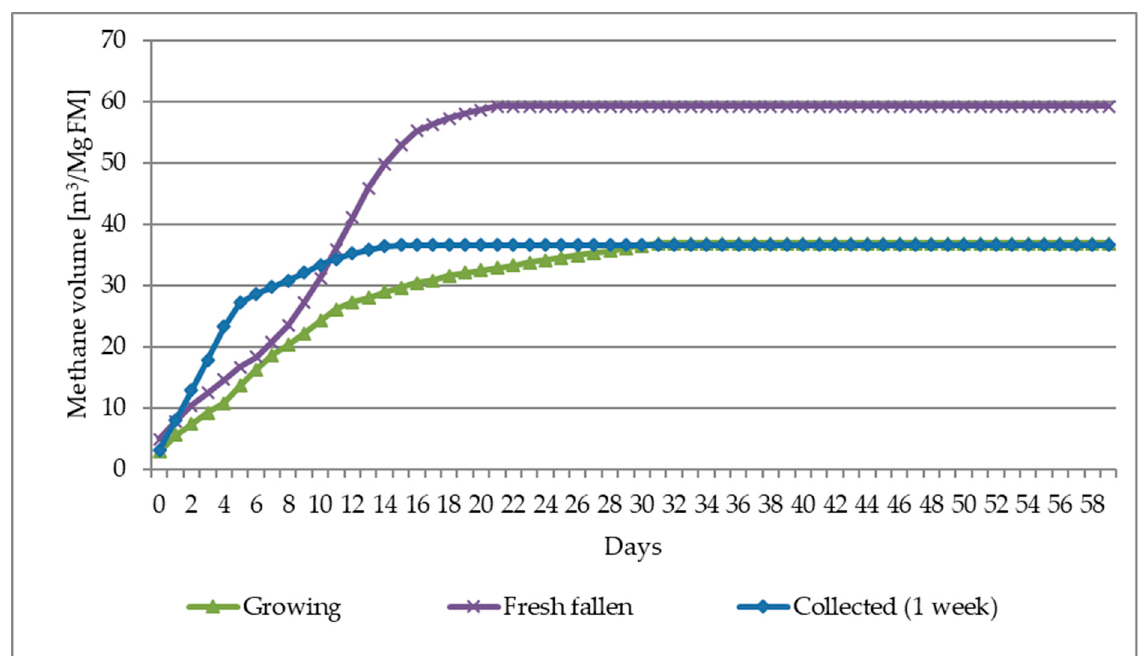
Figure 6. Methane production from fresh mass in time.